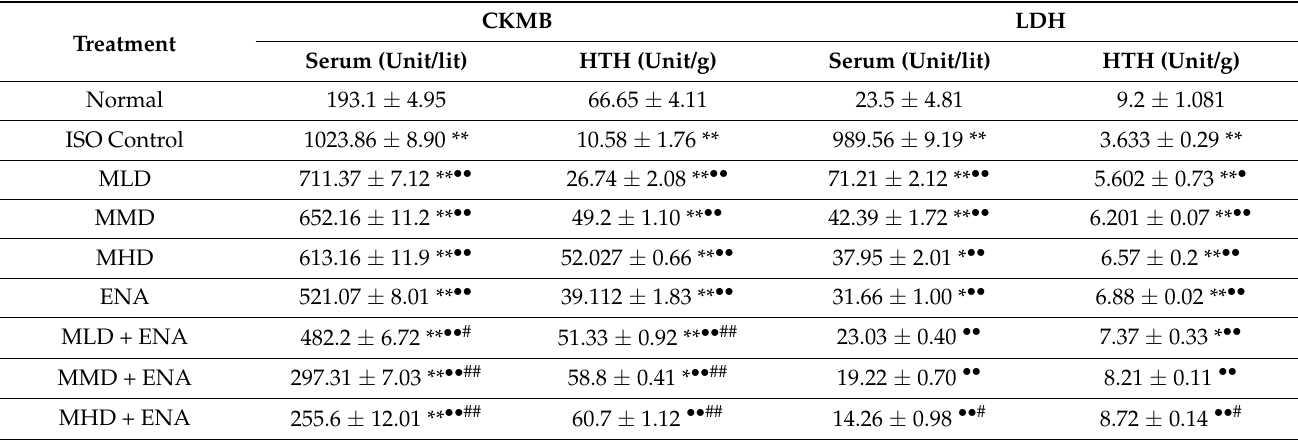
Table 1. Effect on CKMB and LDH activities in the serum and heart tissue homogenate against isoprenaline-induced acute myocardial damage.